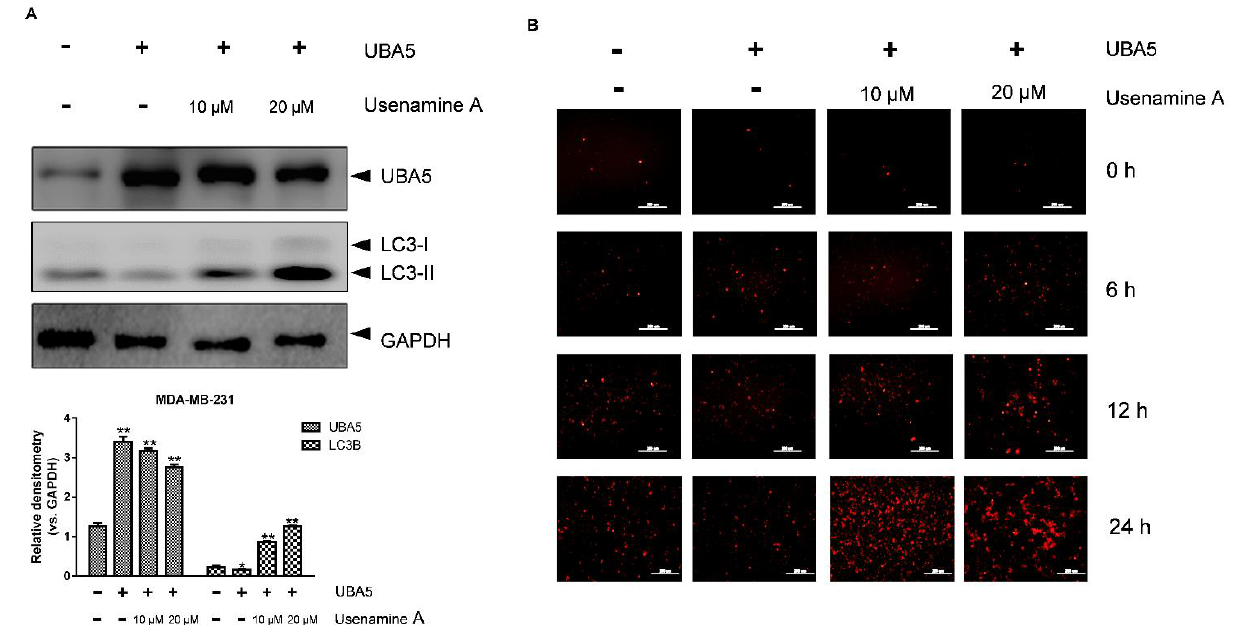
Figure 6. Overexpression of UBA5 inhibited autophagic activity in MDA-MB-231 cells. ( A ) Western blotting analysis of UBA5 and LC3B protein expression in MDA-MB-231 cells with or without the overexpression of UBA5. The cells were transfected with UBA5 for 24 h, rhen the medium was replaced with fresh growth medium, and the cells were treated with usenamine A (10 µ M, 20 µ M) or left untreated. ( B ) Immunofluorescence of RFP-LC3B (Red). The cells were transfected with UBA5 and RFP-LC3B for 24 h. After transfection, the cells were cultured in standard growth medium and treated with usenamine A (10 µ M, 20 µ M) or left untreated. Fetal bovine serum (FBS) was used as a supplement to culture MDA-MB-231 cells. * p < 0.05, ** p < 0.01 and *** p < 0.001 compared to the control